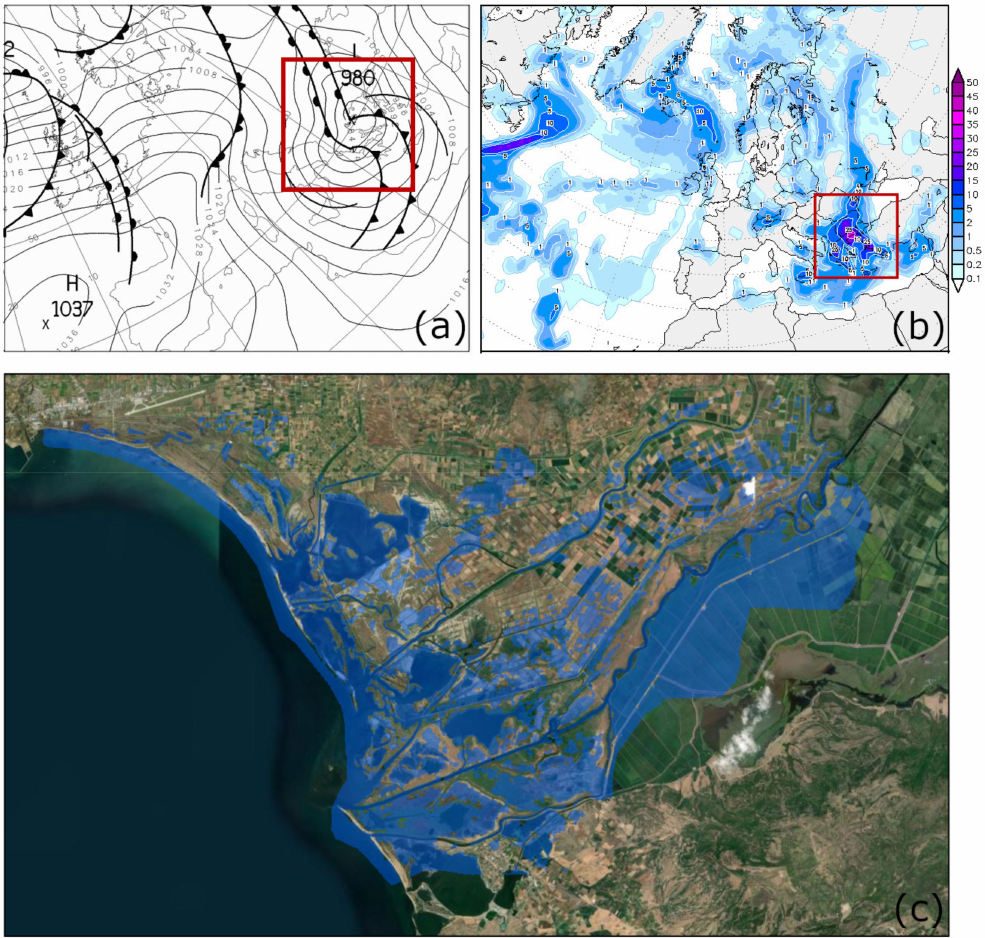
Figure 2. ( a ) Surface weather chart and ( b ) the respective precipitation map at a time close to the reported onset of the 2012 flood event; the red squares indicate the broader study area. ( c ) The flooded area of the Evros river deltaic plain at a time associated with the flood event. The dates corresponding to each map are given in Table 1 (see Meteorological Event Date and Satellite Image Acquisition Date,